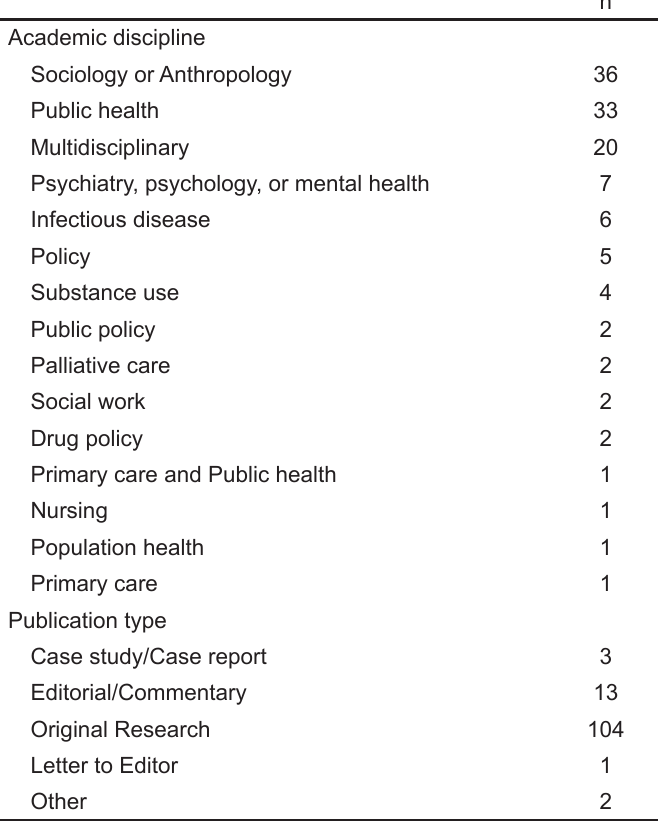
Table 2. Scoping review article